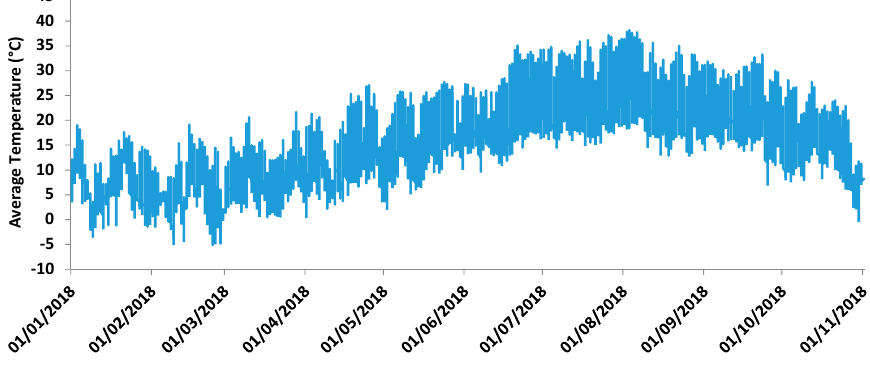
Figure 12. Average temperature measured over 10 months.